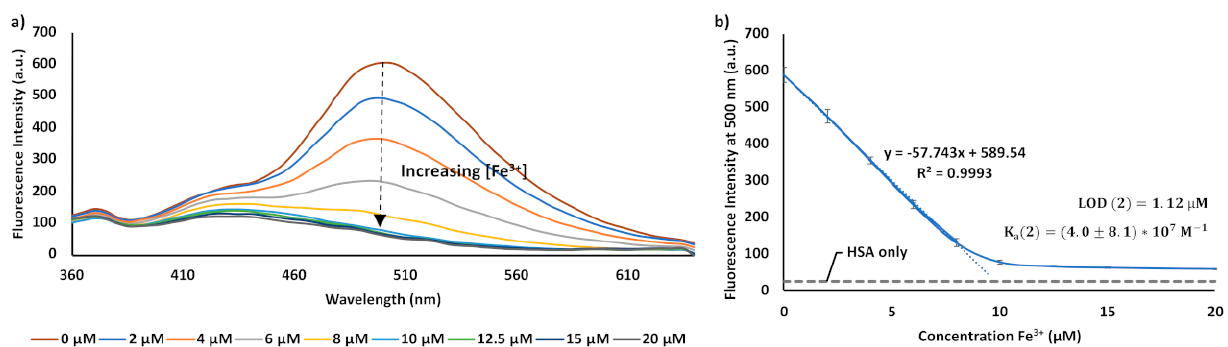
Figure 8. ( a ) Fluorescence quenching seen upon the addition of Fe 3+ to aqueous solutions of 10 µ M 2 containing 20 µ M HSA. ( b ) Fluorescence intensity at 500 nm plotted against [Fe(III)]. All experiments were conducted with excitation at 330 nm and with excitation and emission slit widths of 5 nm, respectively. The inset gives the association constants ( K a ) corresponding to the formation of the 1:1 complex, along with the limit of detection (LOD) determined using the following equation: LOD (x) = 3 × SD F0 × |m x − 1 | where SD F0 = standard deviation of 10 µ M 2 mixed with 20 µ M HSA and m x = the slope of the titration curve.